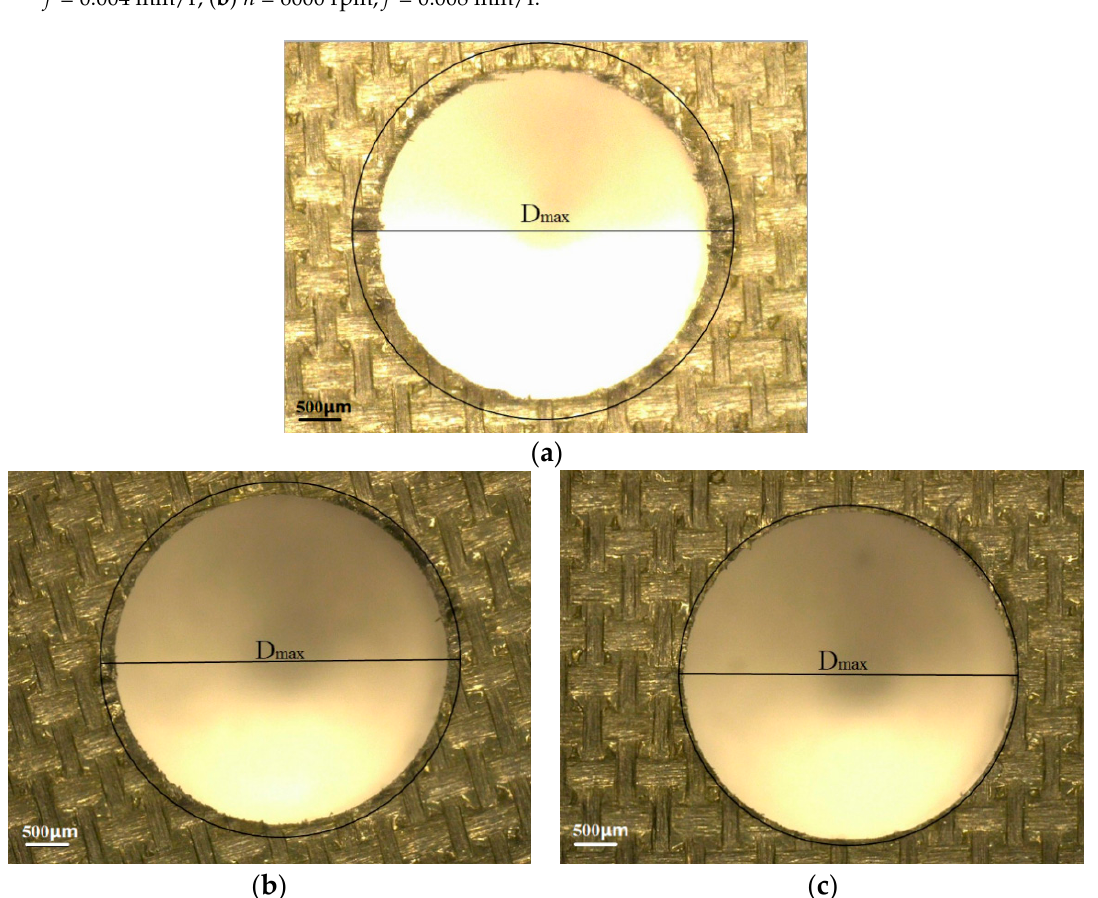
Figure 10. Worn morphology of cutting edge for MCD/NCD coated tools. ( a ) n = 4000 rpm, f = 0.004 mm/r; ( b ) n = 6000 rpm, f = 0.008 mm/r.